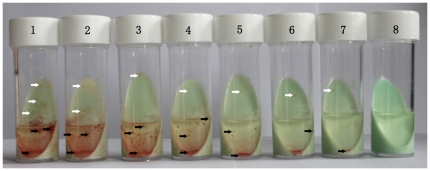
H37Rv culture in biphasic medium.H37Rv ranging in concentration from 107 cfu to 1 cfu per vial were incubated in biphasic medium at 37°C for 2 weeks. The numbers of H37Rv were 107, 106, 105, 104, 103, 102, 10, 1, and 0 CFU/ml in tubes 1 through 8. Both white and black arrows indicate the locations of positive colonies of mycobacteria.